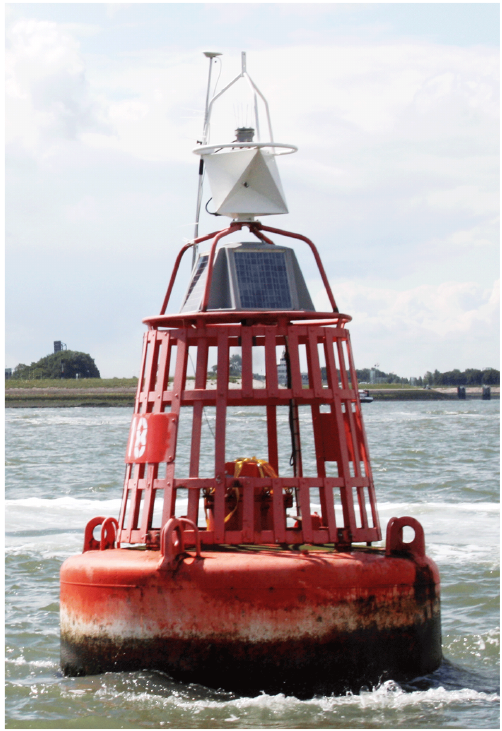
Figure 2. Buoy 18 in the Westerscheldt is located near the town of Terneuzen. On this buoy, a Trimble R7 GPS receiver is mounted inside the cage. The Trimble Zephyr (survey) antenna is installed on a range pole on top of the buoy. Note the eddies induced by the tidal current around the